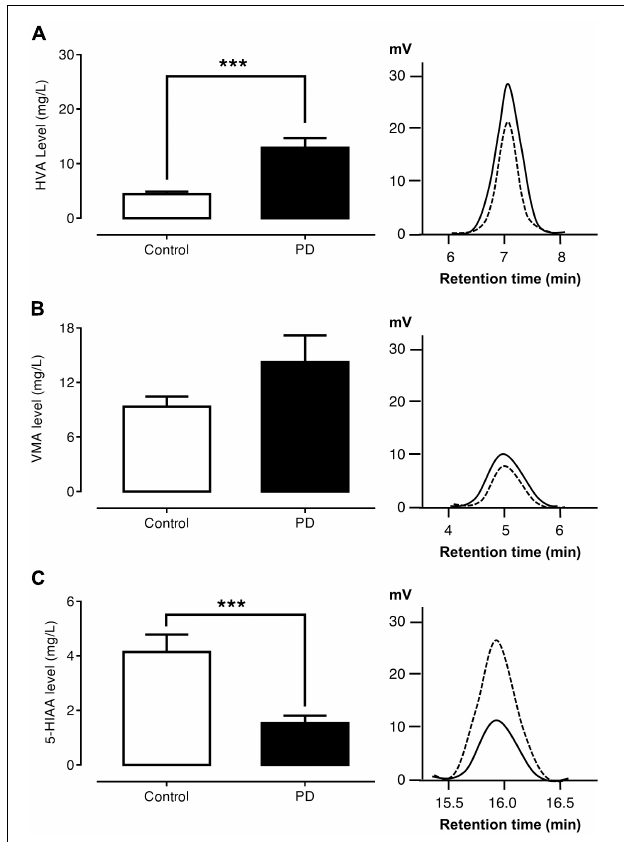
FIGURE 2 | Comparisons of urinary HVA (A) , VMA (B) , and 5-HIAA (C) levels and HPLC chromatograms between control subjects (dash lines) and PD patients (solid lines). Data are presented as mean ± SEM (*** p <